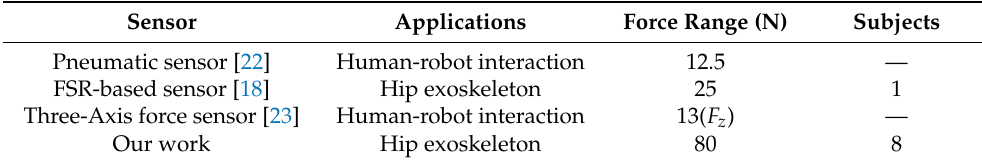
Table 3. Comparisons with relevant